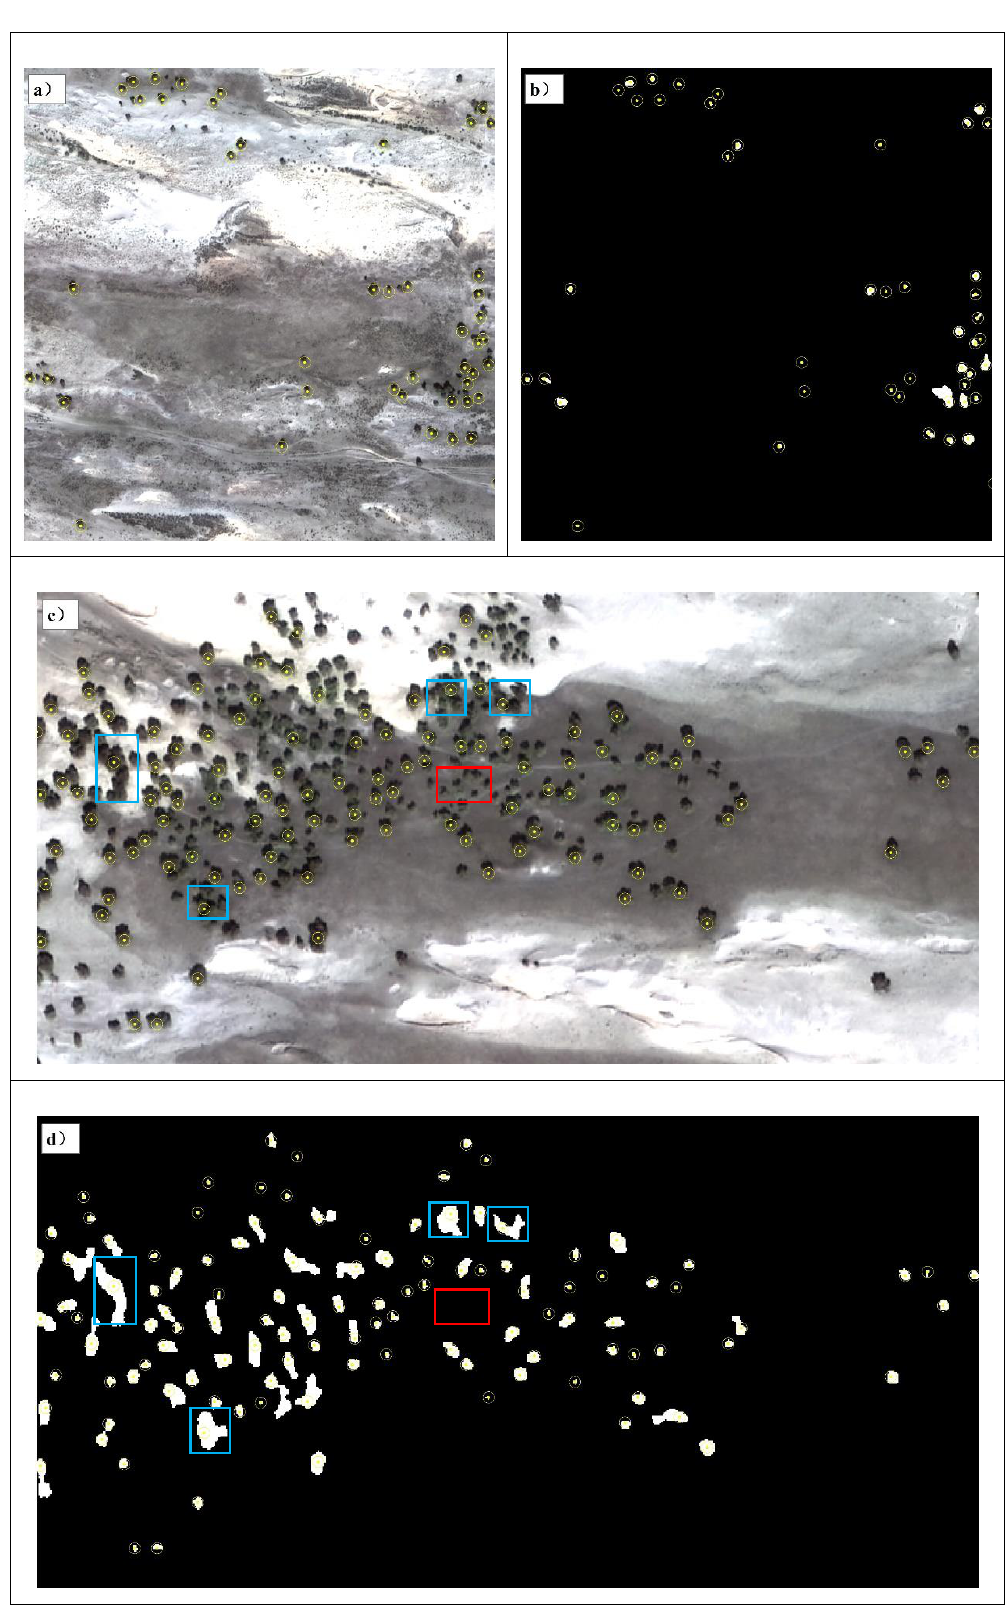
Figure 8. Extraction effect of sparse Ulmus pumila trees in sandy land (partial). ( a , b ) are the location and tree crown extraction results of Ulmus pumila in areas with single trees and contiguous distribution of a few trees; ( c , d ) are the location and tree crown extraction results of Ulmus pumila in areas with contiguous distribution of many